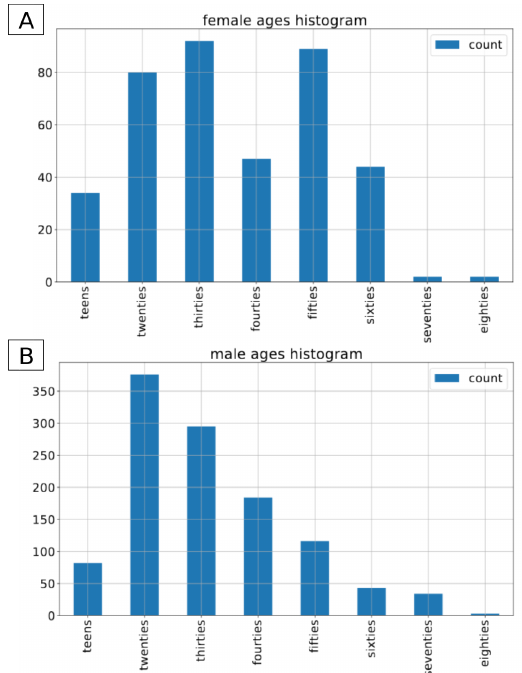
Figure 3. Common Voice: age distribution by gender in the test. ( A ) for female speakers, ( B ) for male